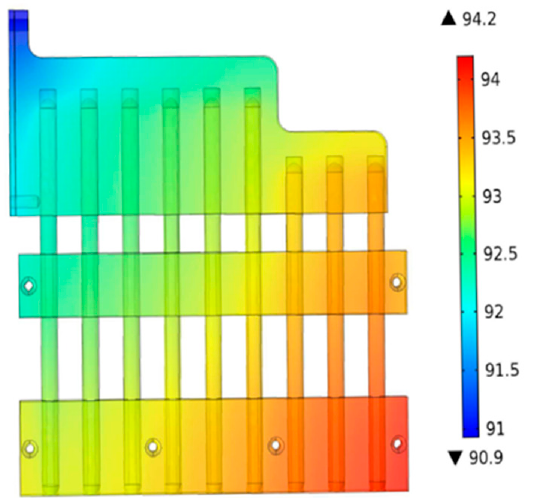
Figure 10. Temperature profile (Type III).